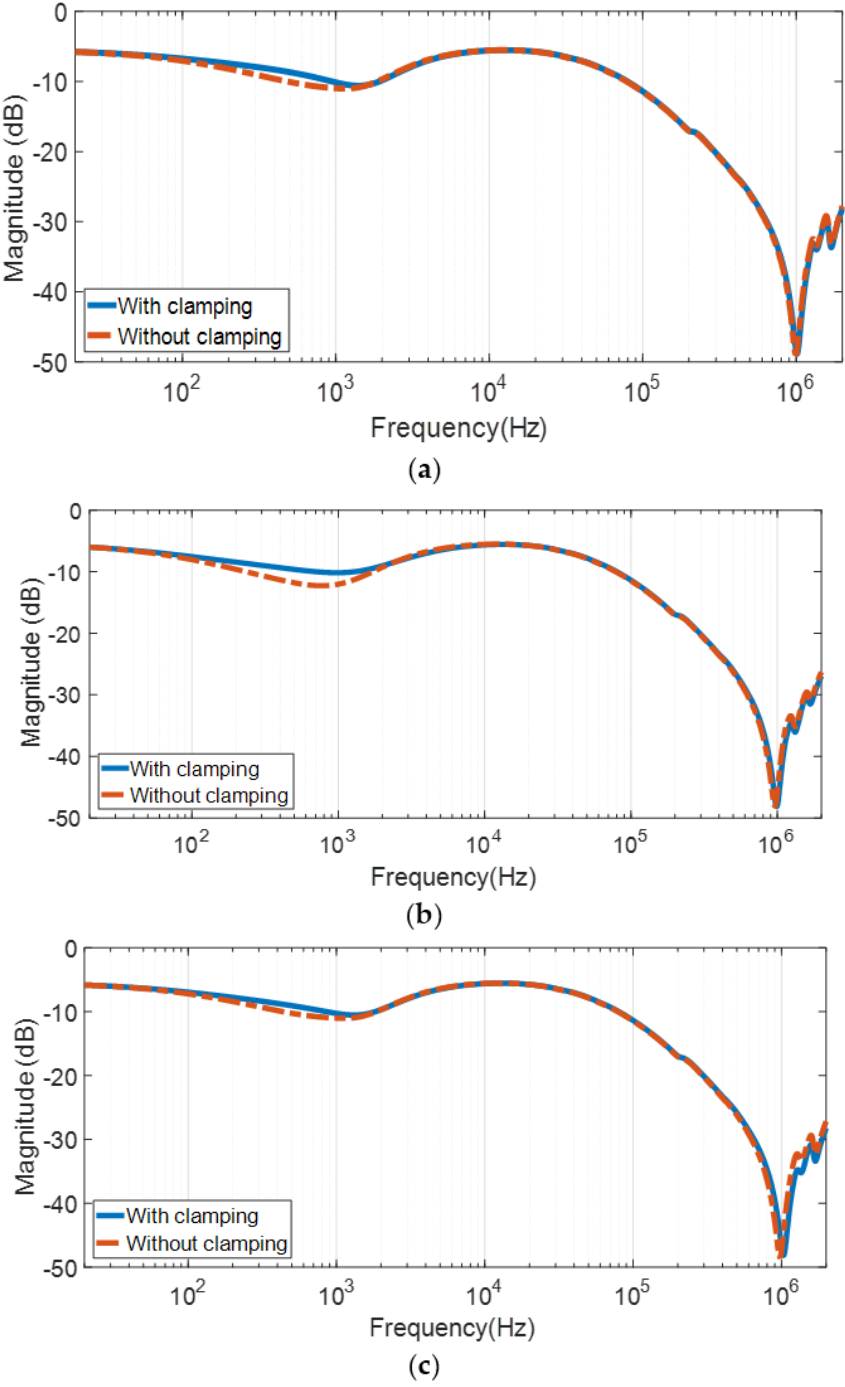
Figure 4 Figure 4. End-to-end open circuit test on the LV winding. Measurement at terminals ( a ) r-n for phase r; ( b ) y-n for phase y; ( c ) b-n for phase